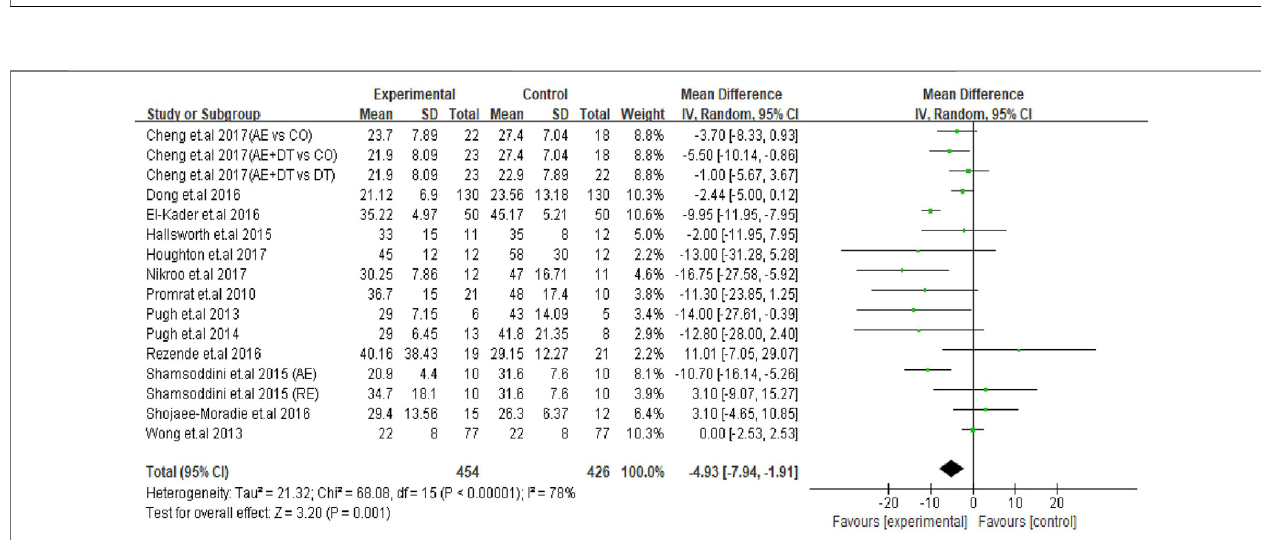
FIGURE 3 | Pooled outcomes of exercise intervention on AST levels in NAFLD/NASH patients. SD, standard deviation; 95% CI, 95% con fi dence interval.